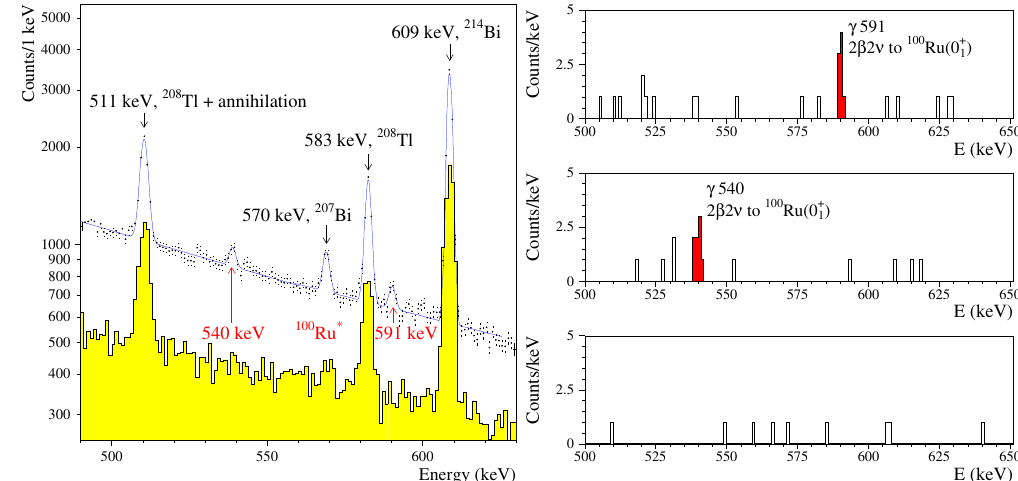
Figure 1. Left : (Color on-line) Energy spectrum collected with the 100 MoO 3 sample (points with error bars) in the (490–630) keV energy region, together with the fit (continuous curve). The background spectrum (normalized to 18120 h) is also shown (filled-in histogram). Both the 540 and 591 keV peaks ) are clearly visible in the energy spectrum of the 100 MoO of the 2 ν 2 β decay 100 Mo → 100 Ru ( 0 + 3 1 sample. Right : (Color on-line) The coincidence energy spectra accumulated over a period of 17807 h with the 100 MoO 3 sample in the four-HPGe setup when the energy of one detector was fixed at ) 2 ν 2 β decay: (540 ± 2) keV (top) and (591 ± 2) keV the value expected for the 100 Mo → 100 Ru ( 0 + 1 (middle). The bottom figure shows the background obtained by shifting the energy of one detector to (545 ± 2)